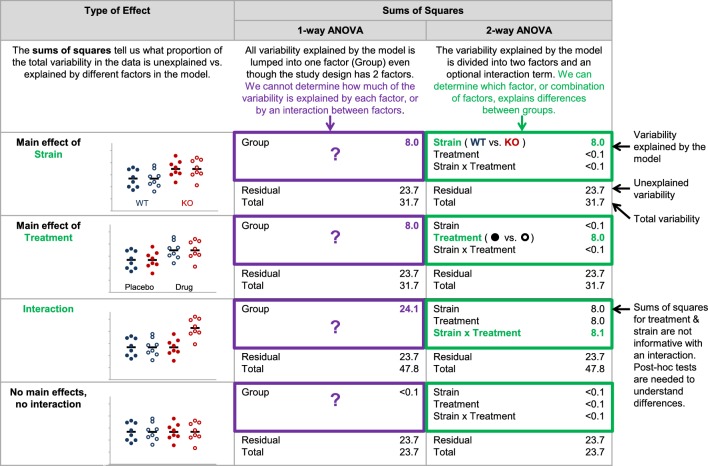
Why it matters whether investigators use a one-way vs two-way ANOVA for a study design with two factors.The two-way ANOVA allows investigators to determine how much of the variability explained by the model is attributed to the first factor, the second factor, and the interaction between the two factors. When a one-way ANOVA is used for a study with two factors, this information is missed because all variability explained by the model is assigned to a single factor. We cannot determine how much variability is explained by each of the two factors, or test for an interaction. The simulated dataset includes four groups – wild-type mice receiving placebo (closed blue circles), wild-type mice receiving an experimental drug (open blue circles), knockout mice receiving placebo (closed red circles) and knockout mice receiving an experimental drug (open red circles). The same dataset was used for all four examples, except that means for particular groups were shifted to show a main effect of strain, a main effect of treatment, and interaction between strain and treatment or no main effects and no interaction. One- and two-way (strain x treatment) ANOVAs were applied to illustrate differences between how these two tests interpret the variability explained by the model.